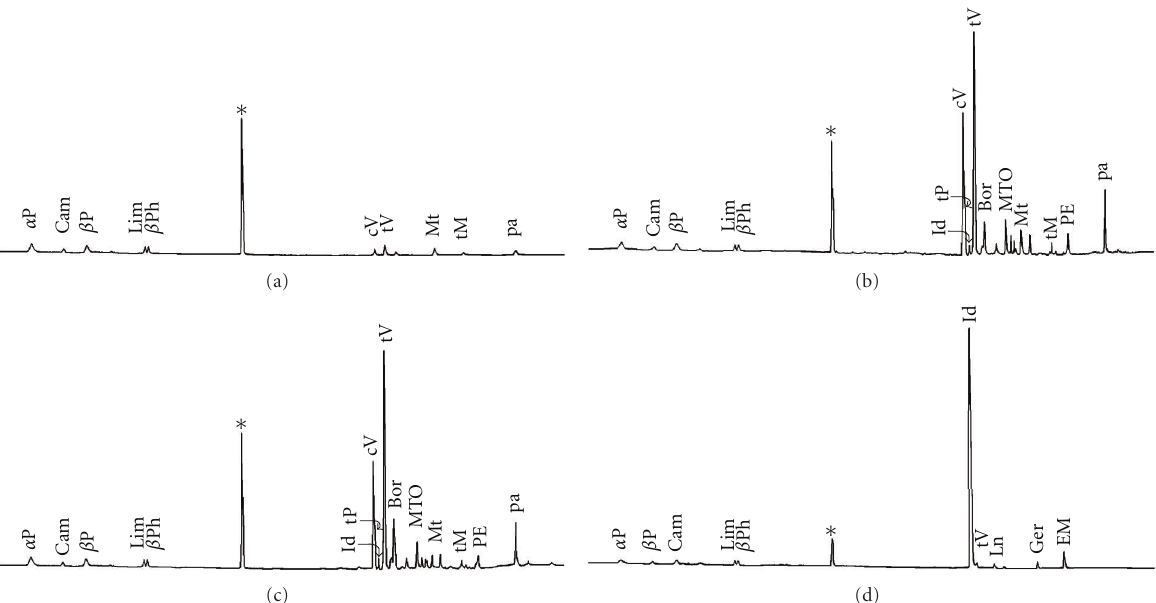
Figure 2: GC chromatograms from GC-MS analyses of I. pini male hindgut extracts at di ff erent overwintering/diapause status. α P: α -pinene; Cam: camphene; β P: β -pinene; Lim: limonene; β Ph: β -phellandrene; Id: ipsdienol; cv: cis -verbenol; tP: trans -pinocarveol; tV: trans -verbenol; Bor: borneol; MTO: oxygenated monoterpenes; Mt: myrtenol; Ger: geraniol; tM: trans -myrtanol; EM: E -myrcenol; Pa: perilla alcohol; Ln: lanierone; PE: 2-phenyl ethanol ∗ : internal quantification standard, heptyl acetate (C 7 Ac) amount varies between sample—see the following. (a) Late fall; in diapauses, 5 males; C 7 Ac is 100 ng. (b) Overwintering, cut out of bolts; 8 males; C 7 Ac is 1000 ng. (c) Overwintering, cut out of bolts, on new bolts 48hrs; 5 males; C 7 Ac is 1000 ng. (d) Overwintering, cut out of bolts, on new bolts 96 hrs; 10 males; C 7 Ac is 1000